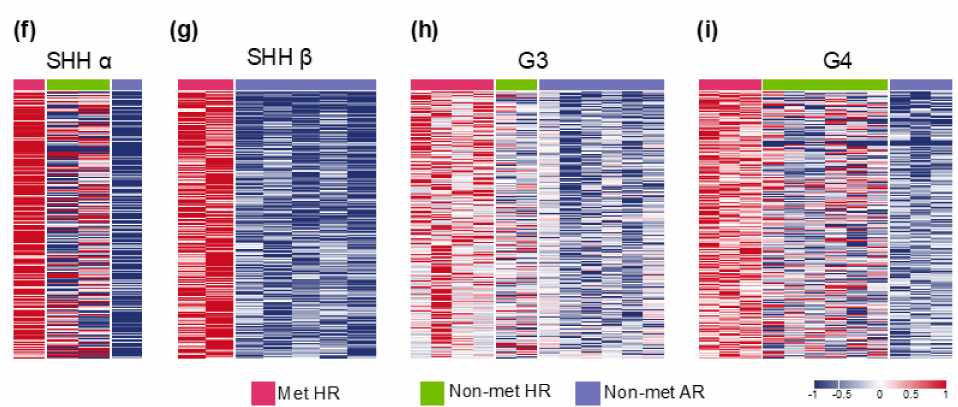
Figure 2. Molecular subgroups and the distribution of clinical parameters in the cohort series of 52 pediatric MBs in Taiwan. ( a ) Subgroup classification by using RNA-Seq. ( b ) Subgroup classification by using DNA-methylation array. ( c ) t-SNE dimensional distribution of the four core molecular subgroups. ( d ) Subtype classification of SHH subgroup. ( e ) t-SNE dimensional distribution of SHH subtypes. ( f – i ) MBs with metastasis found at diagnosis and RNA-Seq performed from primary tumor tissues. Comparing with Non-met AR tumors, subgroup-specific gene expression profiles in Met HR and transition of gene expression profile in Non-met HR tumors were seen across non-WNT molecular subgroups. (f) SHH α MB (Met HR, n = 1). ( g ) SHH β MB (Met HR, n = 2), ( h ) Group 3 (Met HR, n = 4). ( i ) Group 4 (Met HR, n =